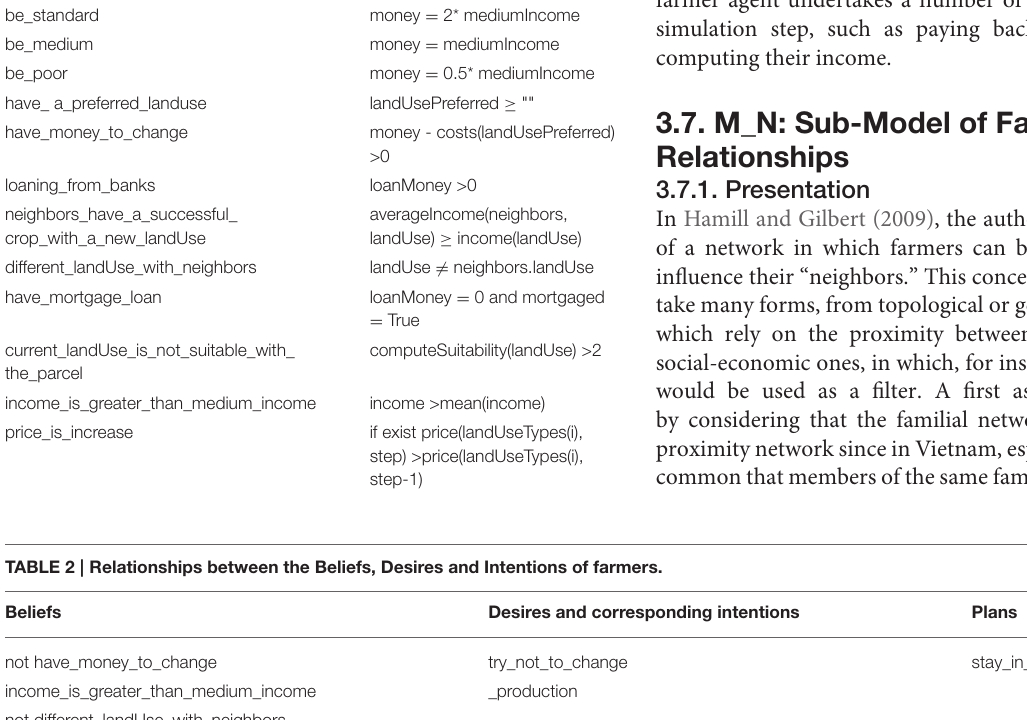
TABLE 1 | Beliefs base of farmers and conditions for the update_beliefs function. Belief Condition to set